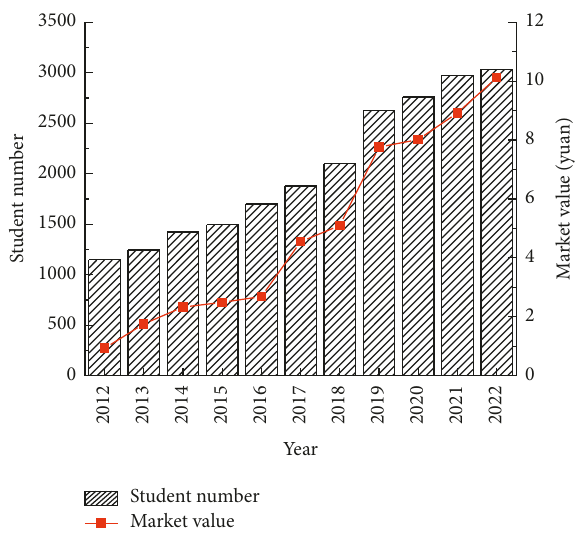
Figure 1: Growth trend of the number of music training students and the total value of the music training market in